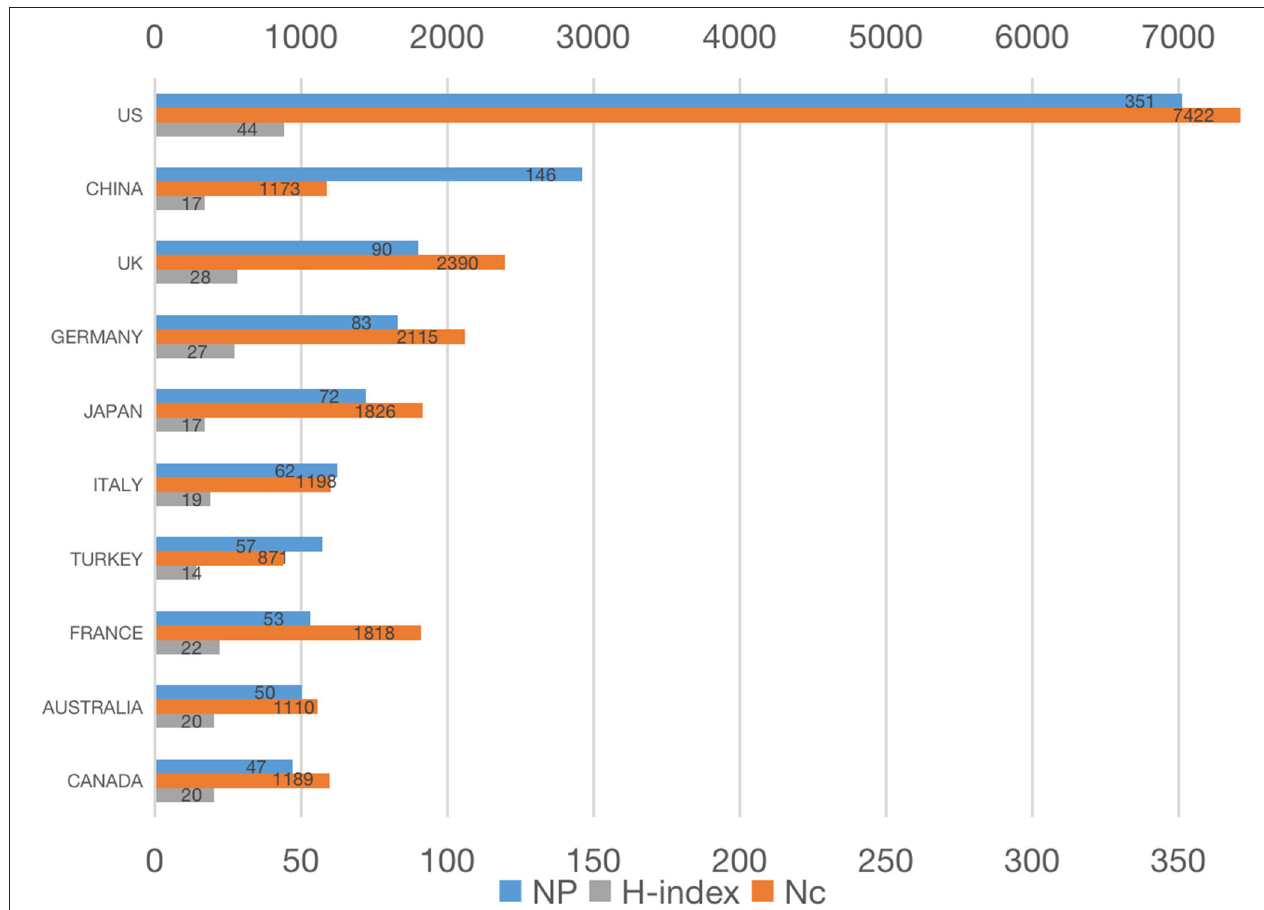
FIGURE 4 | Total publications, H-index, and the total citation of top 10 countries/regions.